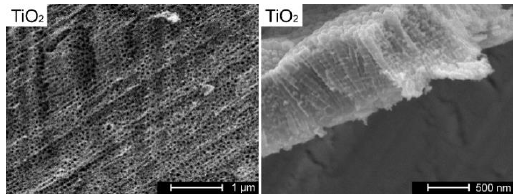
Figure 1. Nanotubular dioxide TiO 2 on the Ti13Zr13Nb alloy (topography—left, thickness—right), Magnifications 16,000 × (on left) and 32,000 × (on right).